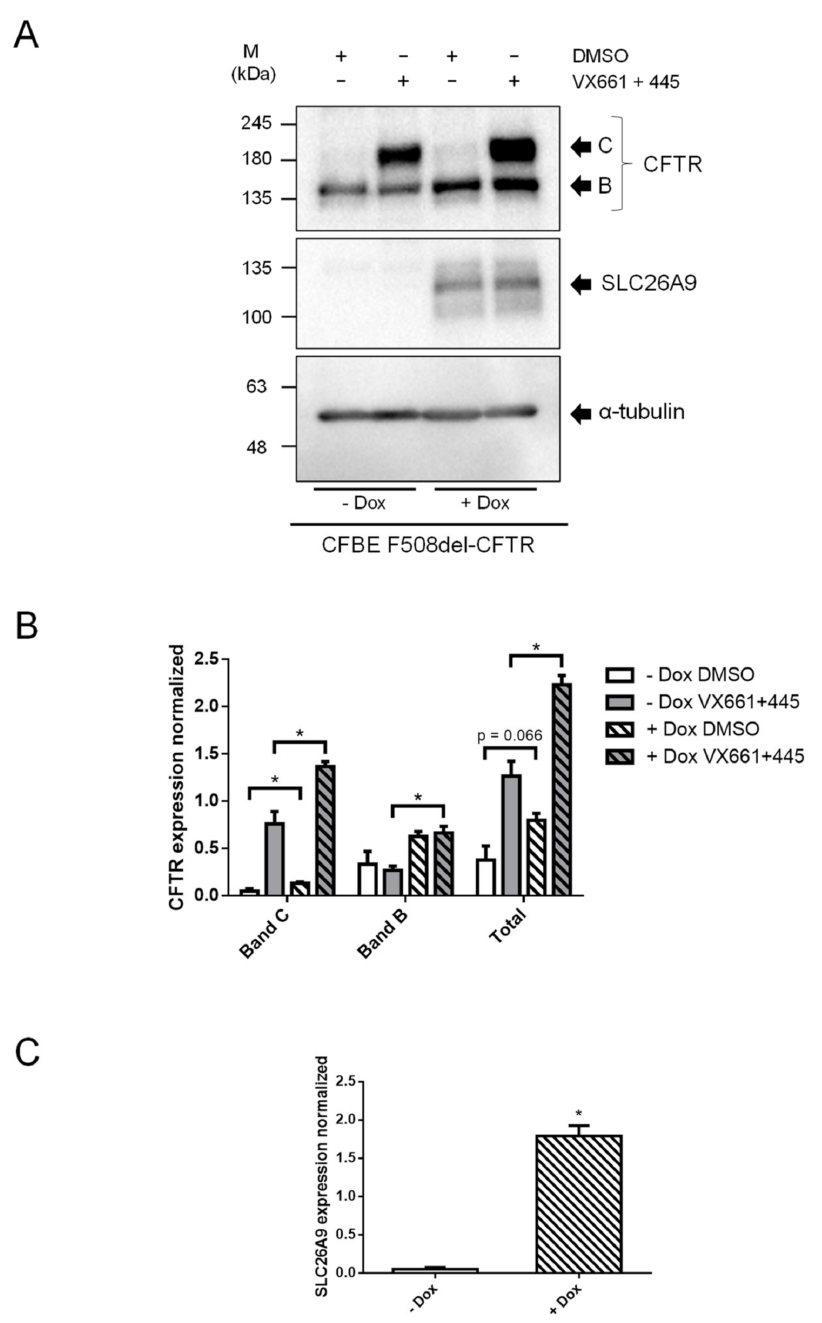
Figure 4. SLC26A9 overexpression increases F508del-CFTR expression and correction by VX-661 + VX-445. ( A ) Western Blot showing CFTR and SLC26A9 expression in CFBE F508del- CFTR cells stably transduced with SLC26A9 in a Tet-On system, where SLC26A9 is only expressed after Doxycycline induction (+Dox). α -tubulin was used as a loading control. ( B ) Quantification by densitometry of CFTR protein expression detected by WB in ( A ). ( C ) Quantification of SLC26A9 expression after Dox induction, as shown in ( A ). Data are normalized to loading control and showed as mean ± SEM ( n = 3). (*) indicates significant differences between cells in the absence ( − Dox) or presence (+Dox) of doxycycline, the latter meaning overexpression of SLC26A9 (unpaired t -test, p ≤